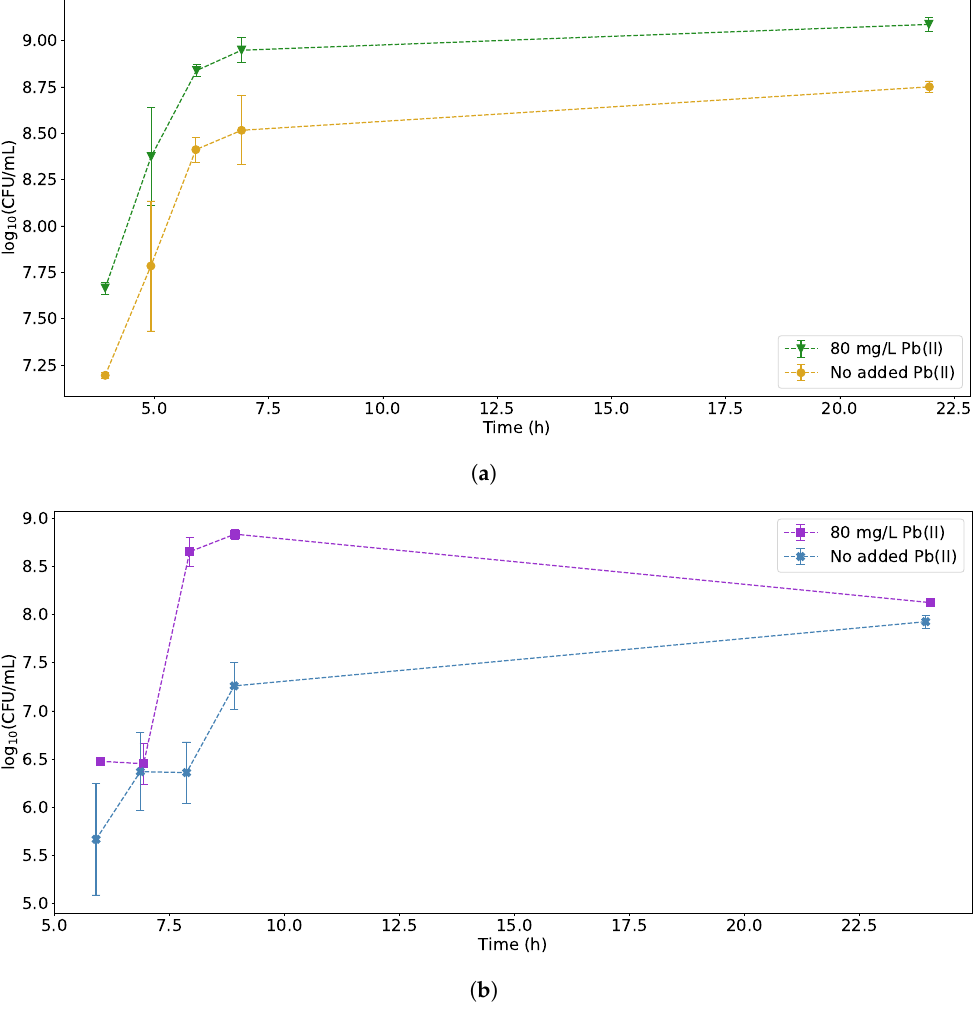
Figure 2. Growth curves for ( a ) K. pneumoniae and ( b ) P. bifermentans with and without addition of Pb(II) to the